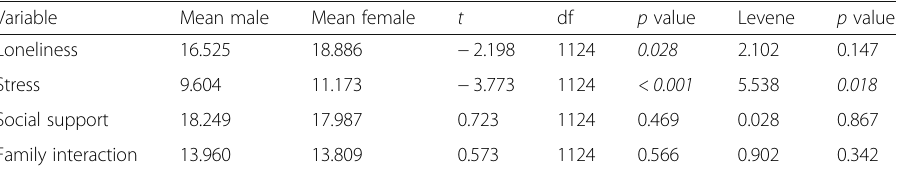
Table 5 t test and Levene ’ s test statistics by gender